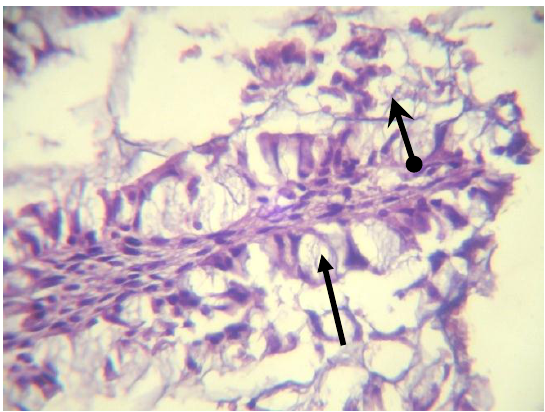
Fig 19: Microscopic section of intestine from 2nd immunized group at 20 post at 20 days post challenge show sever hyper trophy of goblet cells with mucin secretion & lymphocyte proliferation in the sub epithelial layer (H&E X20).